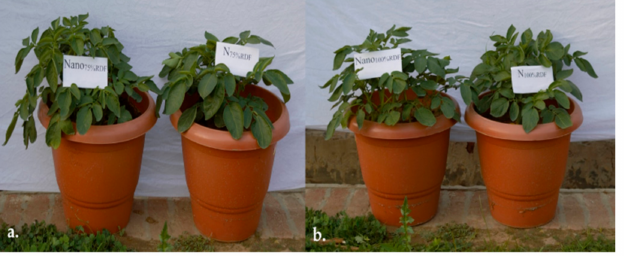
Figure 6. Effect of application of conventional and nano-chitosan-urea composite fertilizer on vegetative growth of potato cv. Kufri Pukhraj: ( a ). N level 75% RDF; ( b ). N level 100% RDF. The shoot fresh and dry weights of the sampled plants were observed to be highest in the NCUC treatment (Table 3). In addition, a dose-dependent effect on the shoot fresh and dry weight parameters was recorded for both the CU and NCUC